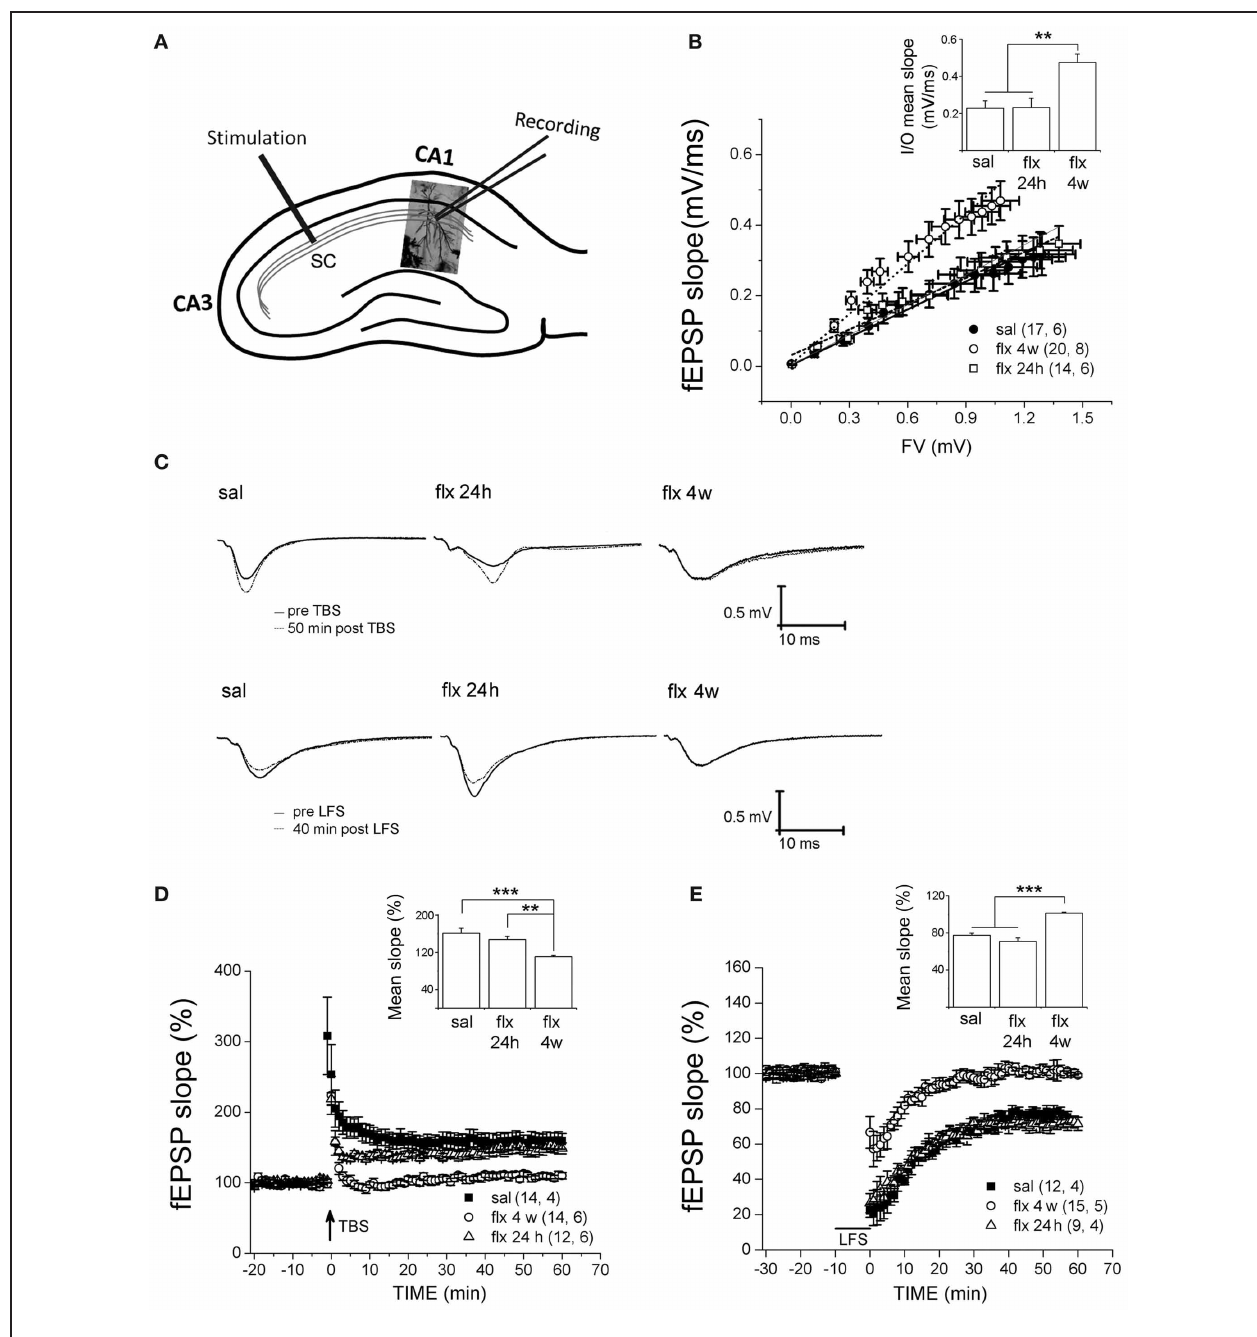
FIGURE 3 | Four weeks of fluoxetine administration affects basal synaptic transmission and synaptic plasticity at CA3-CA1 synapses. Experiments were performed in slices from saline (sal), single (flx 24h), and repeated (flx 4 weeks) fluoxetine treatment groups. (A) The diagram shows the stimulating electrode inserted into Schaffer collaterals (SC) and the recording electrode placed in the CA1 s.r . (B) Input/output curves. The fEPSP slopes vs. increasing presynaptic fiber volley (FV) amplitudes were plotted. Data were fit to a linear regression and compared using covariate analysis. The slope obtained in repetitive fluoxetine-treated rats (0 . 48 ± 0 . 05, r 2 = 0 . 99) was significantly different ( p < 0 . 01) compared to saline-treated rats (0 . 23 ± 0 . 04, r 2 = 0 . 99) or to rats treated with fluoxetine only once (0 . 23 ± 0 . 05, r 2 = 0 . 97). Saline, n = 6 (17 slices); fluoxetine 24h, n = 6